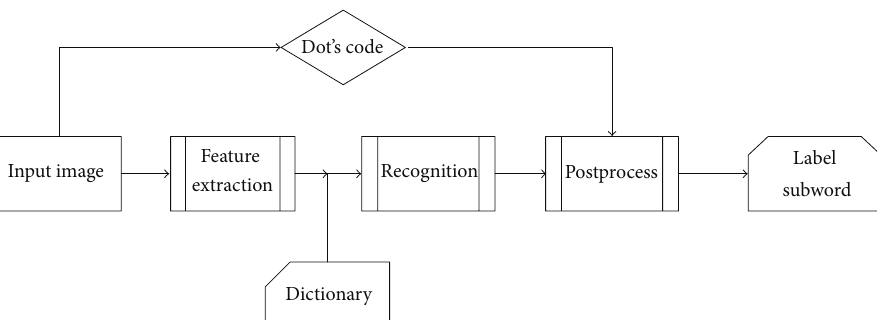
Figure 11: Recognition subsystem is combined with dot recognition modules and postprocessing blocks to recognize subwords.